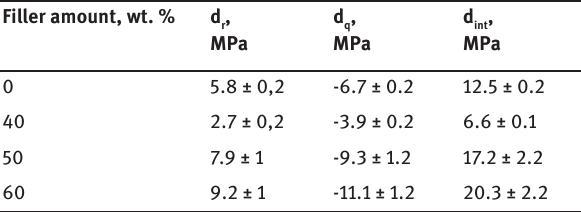
Figure 5: Isochromes in epoxy resin of experimental material with and without filler (0 ÷ 60 wt.%) around restorations, acquired in polarized light with parallel polarization facets. Table 2: The influence of filler amount on the radial stress (d r circumferential stress (d ) and reduced stress (d ) generated during polymerization of experimental dental composite of neat resin and composite filled with 40, 50 or 60 wt. % sialnized silica; photopolymerization conditions - 20 second/1 mm material thickness, the power of light curing unit 1400 mW/cm 2 .